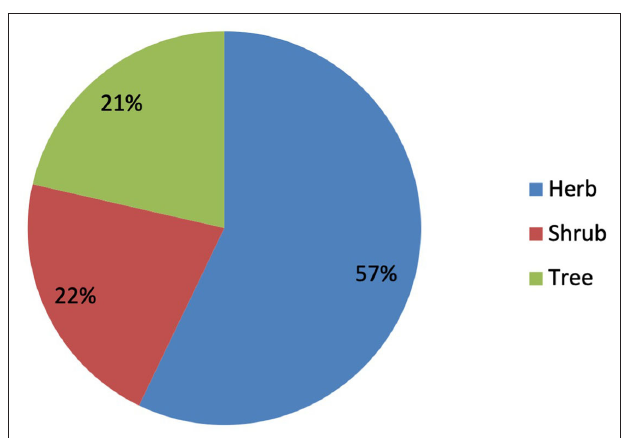
FIGURE 3 | Growth form of the plant species reported from North